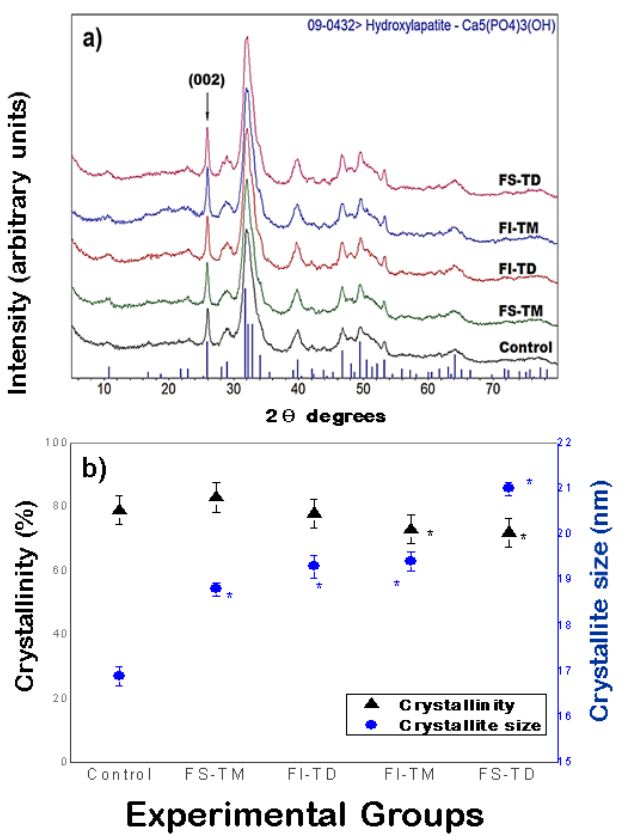
Figure 3. ( a ) X-ray diffractograms of the femurs of male Wistar growing rats fed with soluble and insoluble fiber of O. ficus indica cladodes at early and late maturity stages as the only dietary calcium source and control diet. Identification of the crystalline phase was carried out by using the ICDD-PDF file # 09-0432, corresponding to hydroxyapatite. ( b ) Crystallinity (%) and crystal size in femurs of the experimental groups. FS-TM: Soluble fiber from O. ficus indica at early maturity stage, FS-TD: Soluble fiber from O. ficus indica at late maturity stage, FI-TM: Insoluble fiber from O. ficus indica at early maturity stage, FI-TD: Insoluble fiber from O. ficus indica at late maturity stage. The values represent the mean ± SD n = 7; * significantly different from the values of the bones from rats fed with the control diet ( p ≤ 0.05).